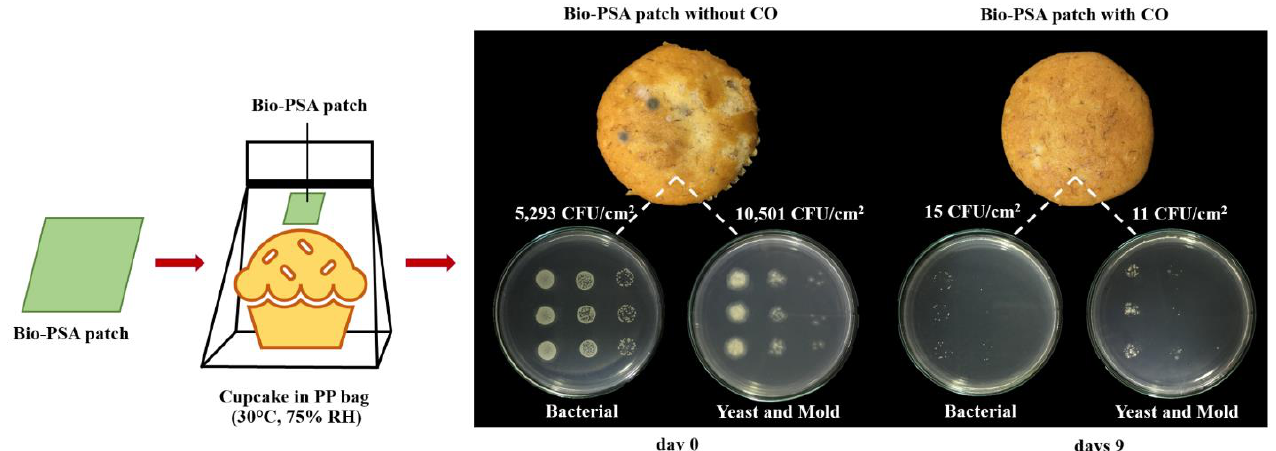
Figure 1. Physical appearance and antimicrobial activity of banana cupcake samples in a polypropylene (PP) bag with and without the natural rubber (NR)-PSA/CO patch at days 9 under 30 °C, 75% room humidity (RH).